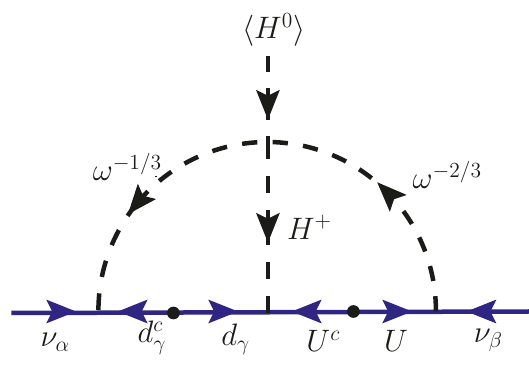
Figure 46 . Two-loop neutrino mass generation in the model of ref. [34] with a LQ and a vector-like quark. This model corresponds to